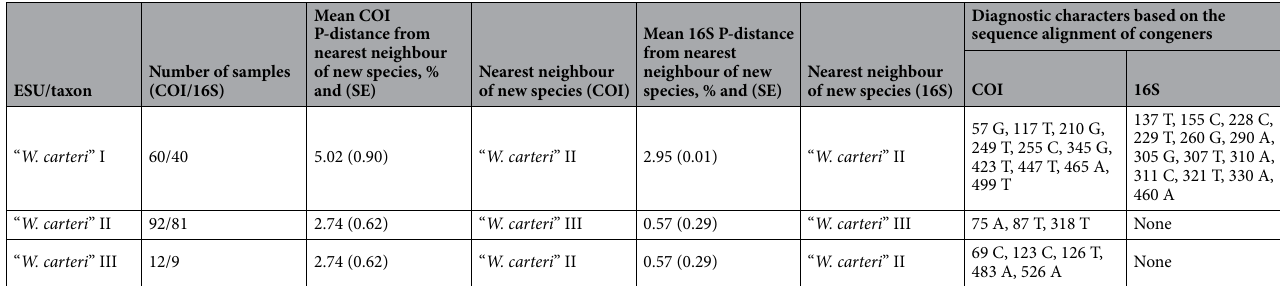
Table 1. Molecular diagnoses of “ Westralunio carteri ” Evolutionarily Significant Units (ESUs) from southwestern Australia (after Bolotov et al. 122 with reanalysis of data from Klunzinger et al . 27 and Benson et al . 28 ). New taxa include “ W. carteri ” II and III. Supplementary files 1 and 2 contain the alignments used to determine the single pure characters and p-distances. The position of each diagnostic character refers to its location within those alignments. SE, standard